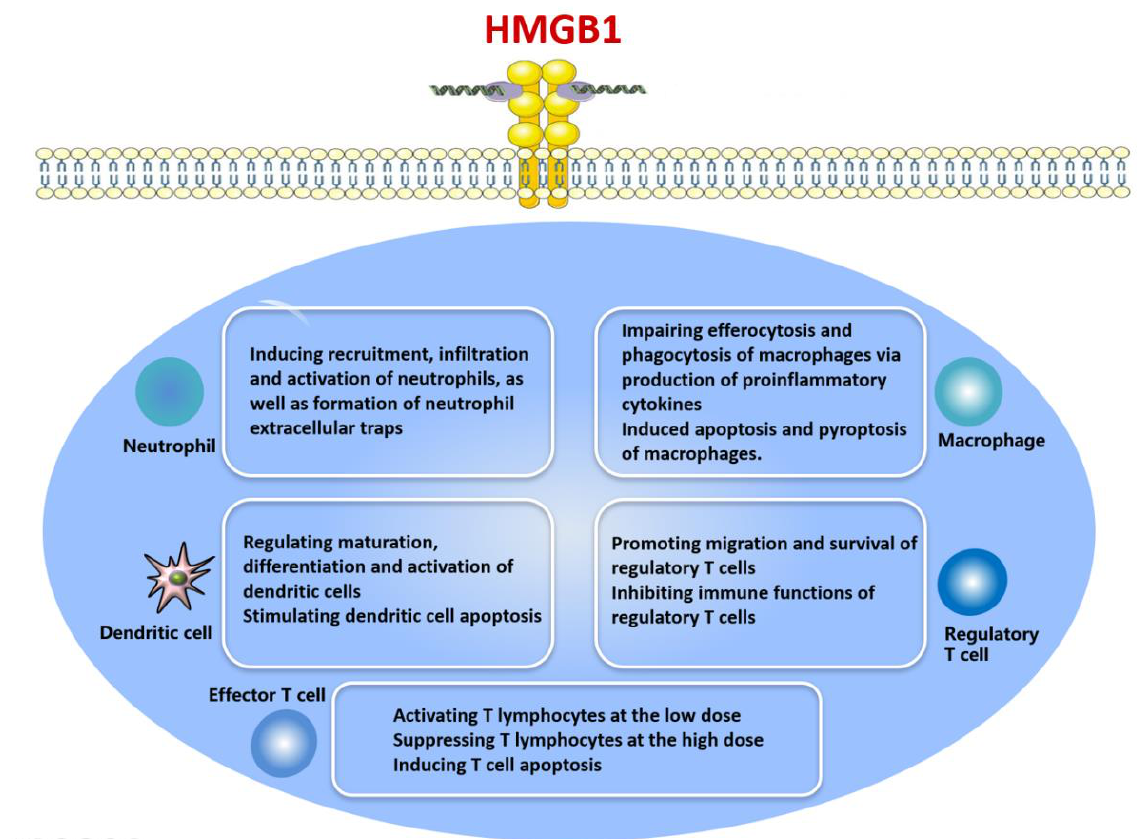
Figure 3. Effects of HMGB1 on different types of immune cell.